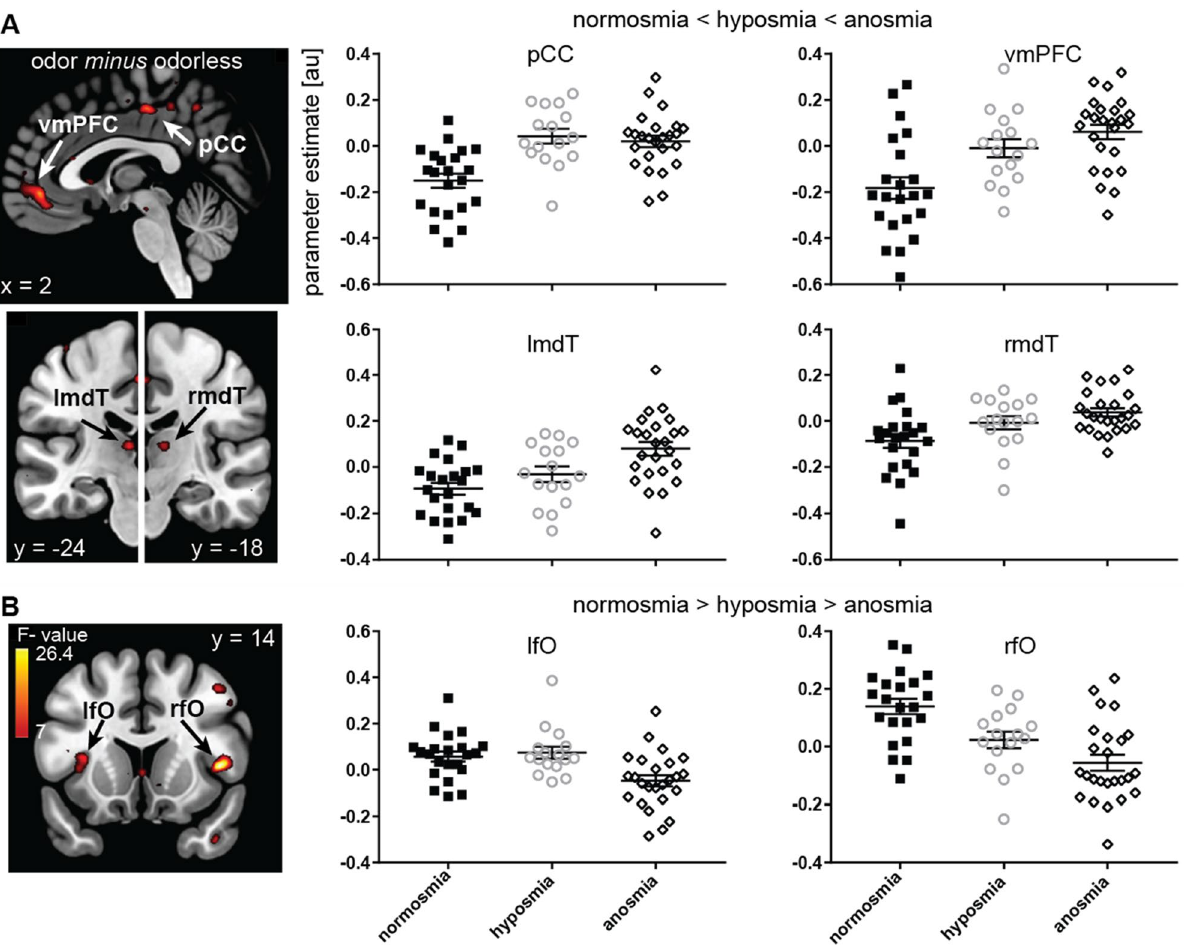
Figure 6. Neural response to odor minus odorless as a function of olfactory impairment. ( A ) clusters in posterior cingulate cortex (pCC), ventromedial prefrontal cortex (vmPFC) and bilateral medio-dorsal thalamus (mdT) showing increasing neural response with increased olfactory impairment, such that participants with anosmia have stronger response than those with hyposmia and those with hyposmia in turn have greater response than those with normosmia. ( B ) clusters in bilateral frontal operculum and left anterior insula (lfO/rfO) showing increased neural responses with increased olfactory function, such that participants with normosmia have greater response than those with hyposmia and those with hyposmia in turn have greater response than those with anosmia. Color gradient scale depicts supra-threshold F values (thresholded at p uncorrected < .005). Other legends as in Fig.